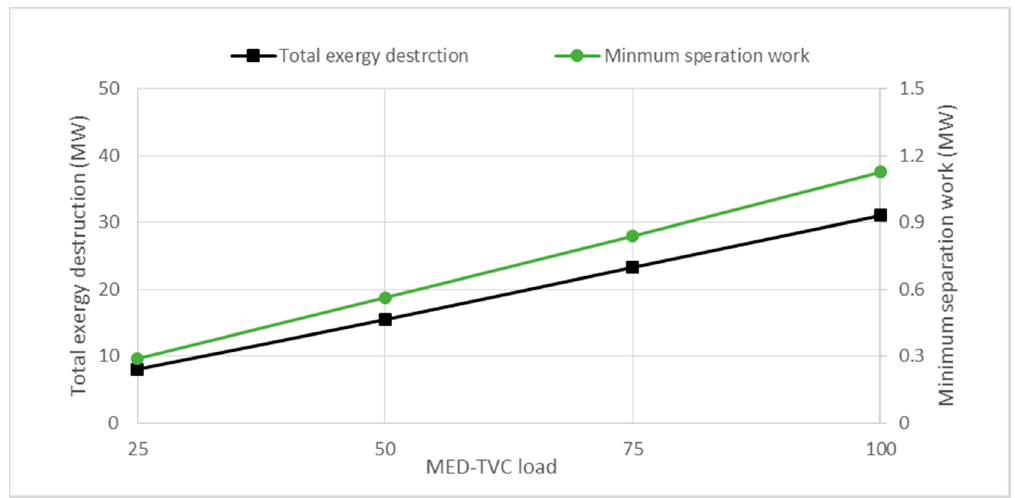
Figure 7. Total exergy destruction and minimum separation work versus plant load.